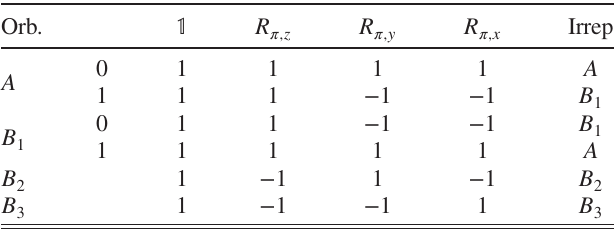
TABLE IV. Characters table of the representations of the little group G for k ¼ R . See caption of Table III. k